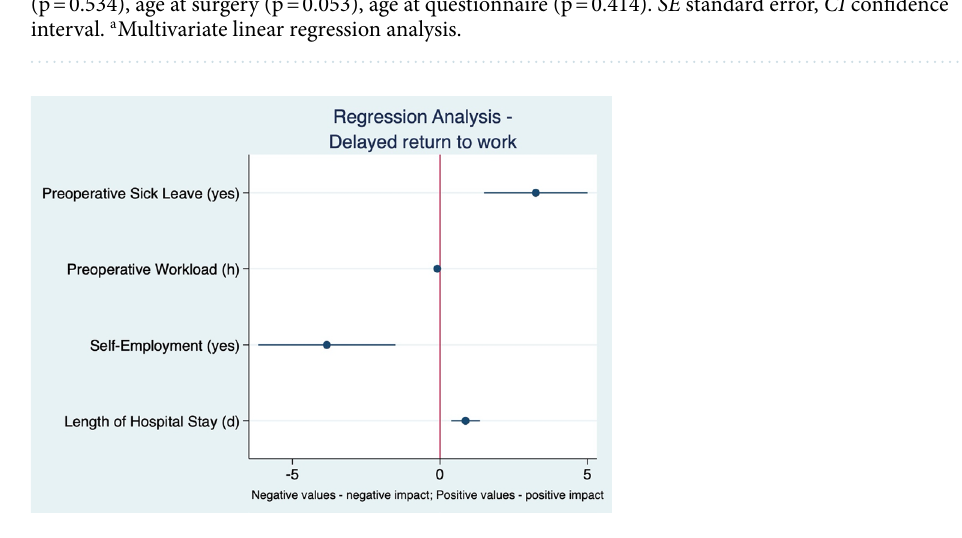
Figure 3. Graphical presentation of multivariate linear regression analysis assessing effect of variables on time to resume work following